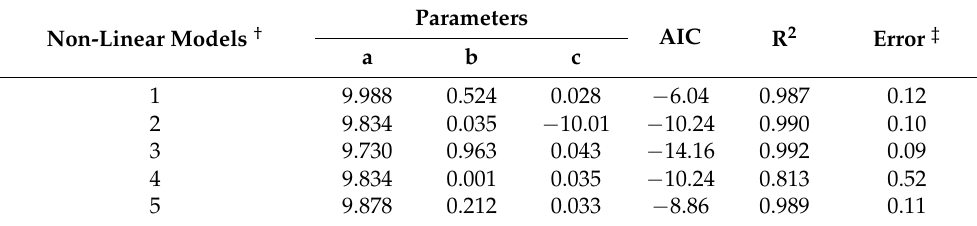
Table 3. Estimated biological parameters, values of Akaike’s information criterion (AIC), coefficient of determination, and absolute error of the adjusted models for the estimation of water disappearance in the growing–finishing phase, according to the pigs’ housing period.